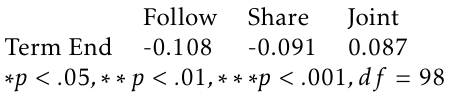
Table 6. Correlation between Network Centrality and Term Ending year for all senators